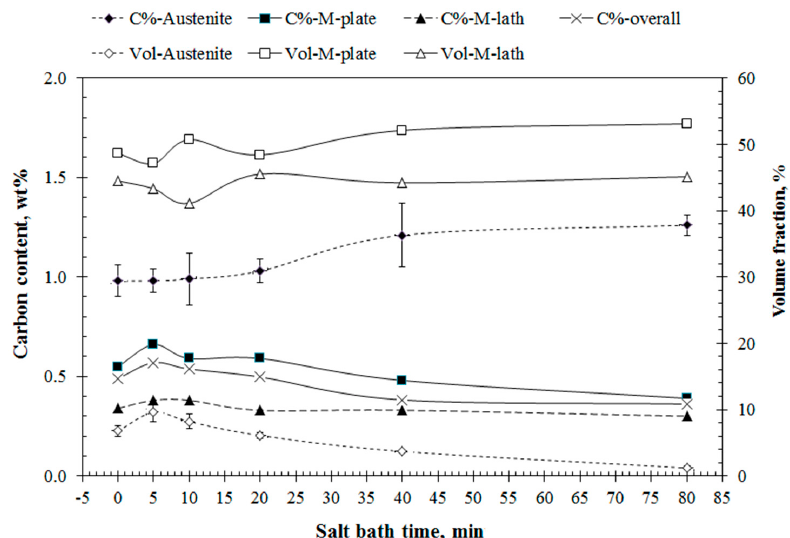
Figure 8. Quantified results of XRD analyses: Effect of austempering time on the volume fraction, carbon content and lattice strain of the matrix phases.